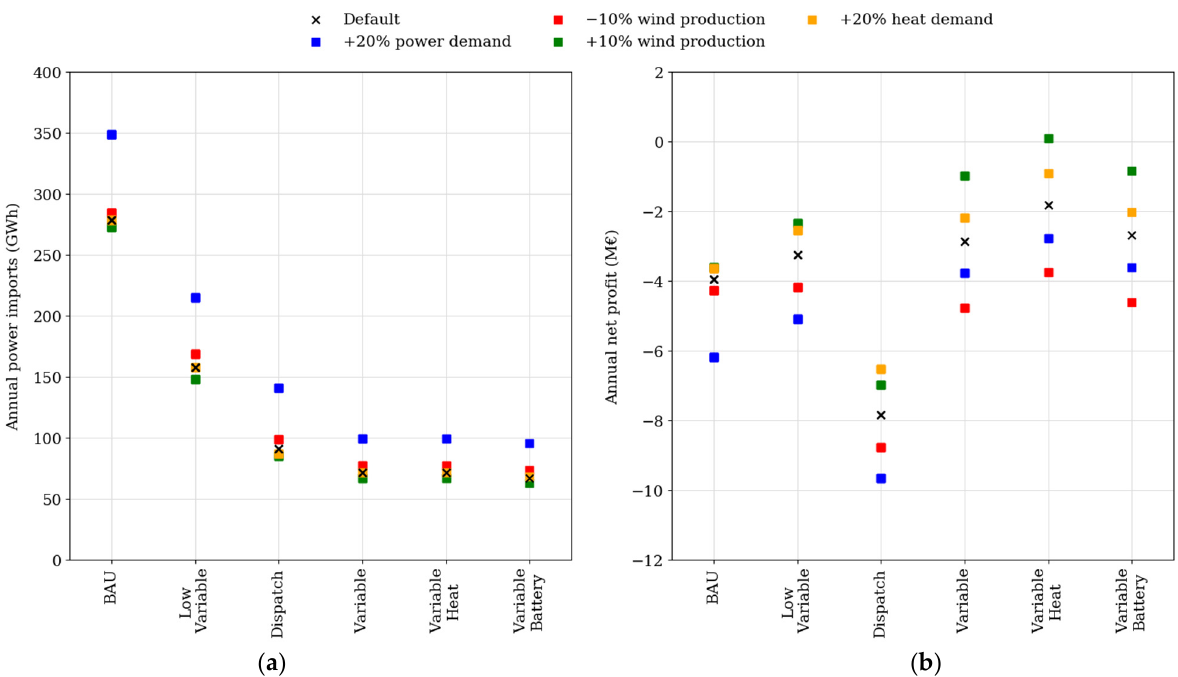
Figure 4. Sensitivity analysis consisting of four separate assumption changes in comparison to default scenarios: ( a ) system power imports and ( b ) system net profit.